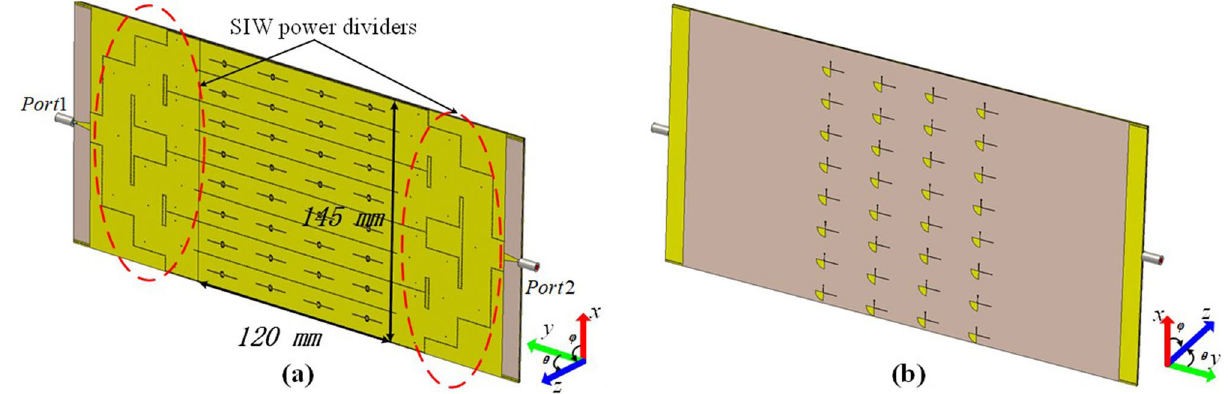
Figure 5. 3D schematic of SIW-slot antenna array. ( a ) Front view. ( b ) Bottom view.